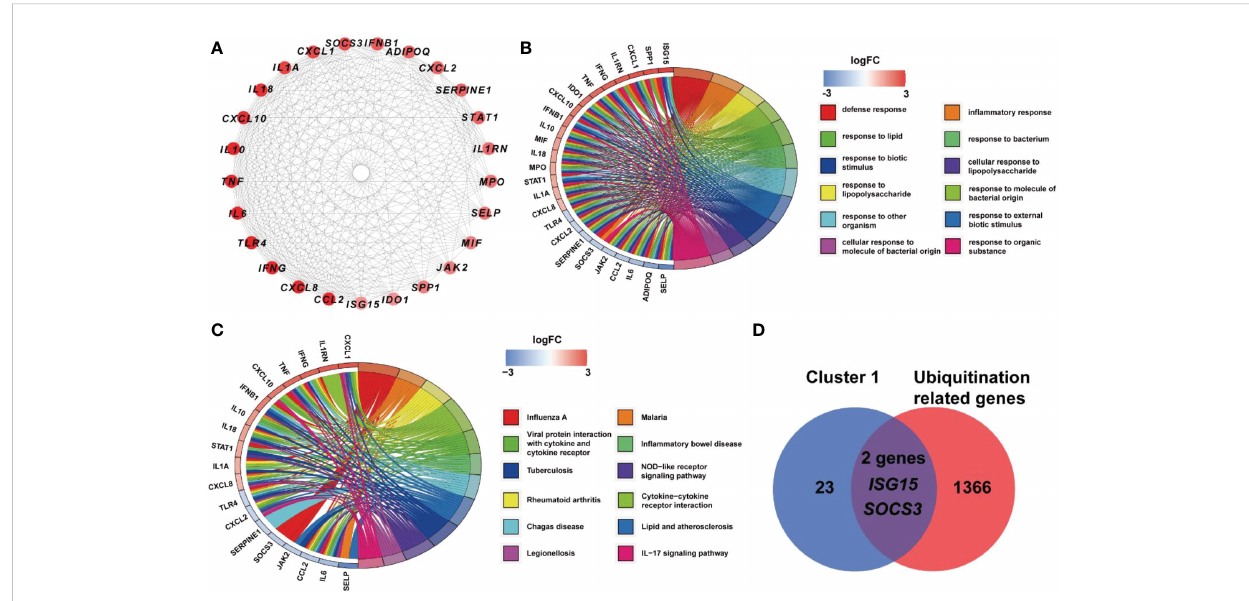
FIGURE 4 Analysis of cluster 1 from PPI network. (A) Cluster 1 contained 25 genes. (B) BP results from GO enrichment analysis of Cluster 1. (C) KEGG pathway analysis of genes in Cluster 1. (D) Two genes in Cluster 1 were